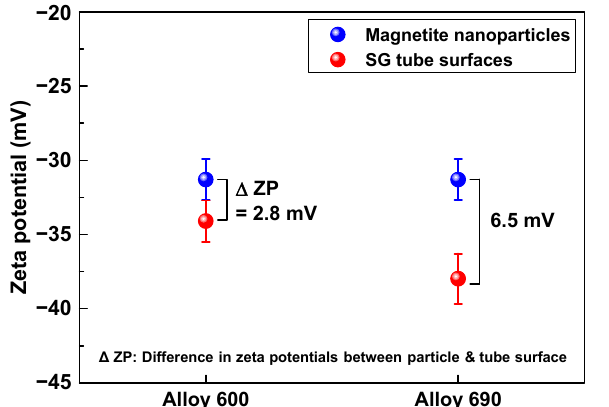
Figure 5. Zeta potential of magnetite particles and surface zeta potentials of Alloy 600 and Alloy 690 flat specimens.